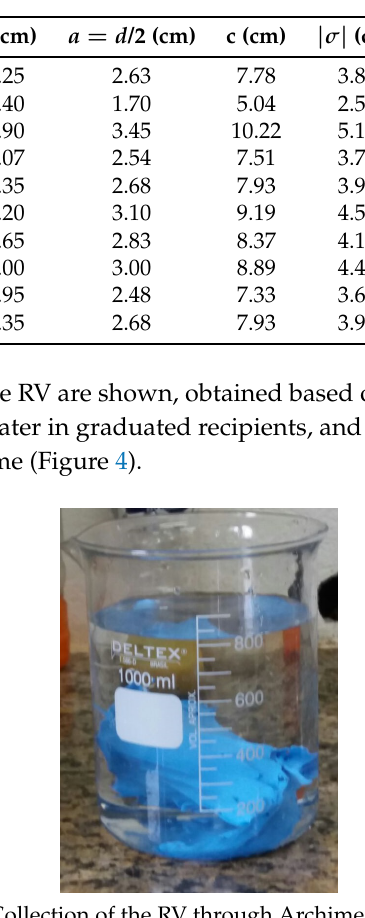
Table 1. Measurements determined from the manufactured molds and which will be the considered data to feed the models.